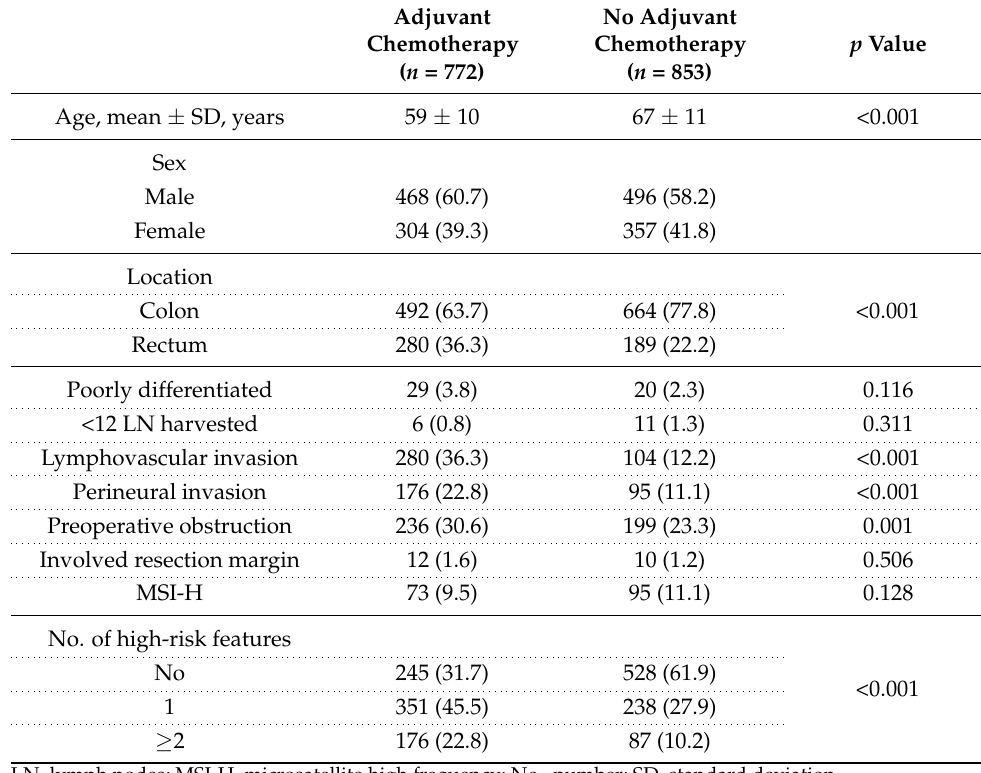
Table 2. Clinicopathologic characteristics of patients with pT3N0 colorectal cancer according to the addition of adjuvant chemotherapy in the overall